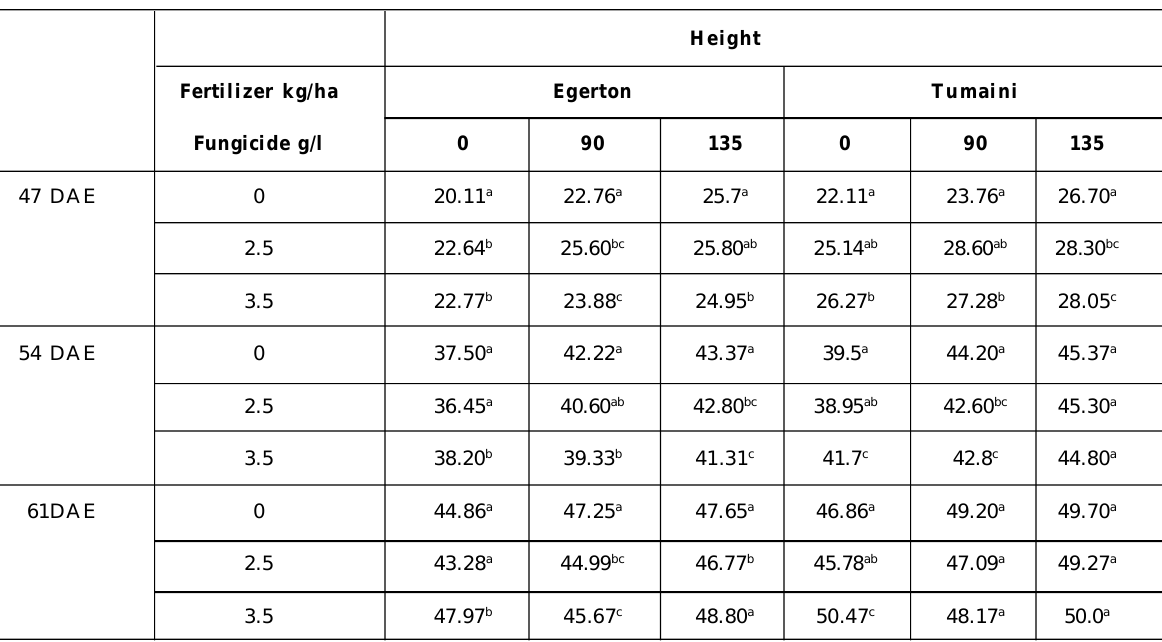
Table 3: Effects of fertilizer and fungicide rates on height of potatoes